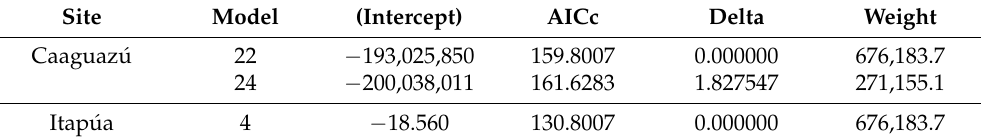
Table 4. Plausible models for the regeneration of planted species in the two agroforestry experiments.